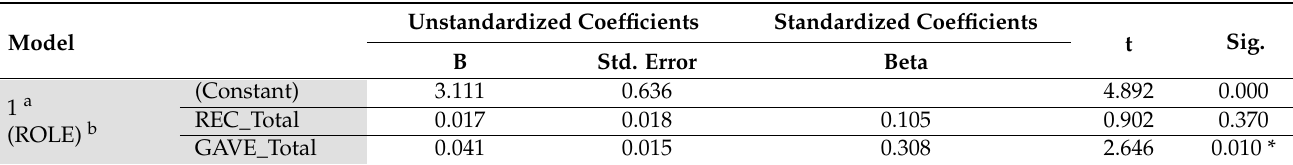
Table 2. Multiple regression analysis predicting students’ performance on the Final Version based on the roles that students assume (giving vs. receiving).